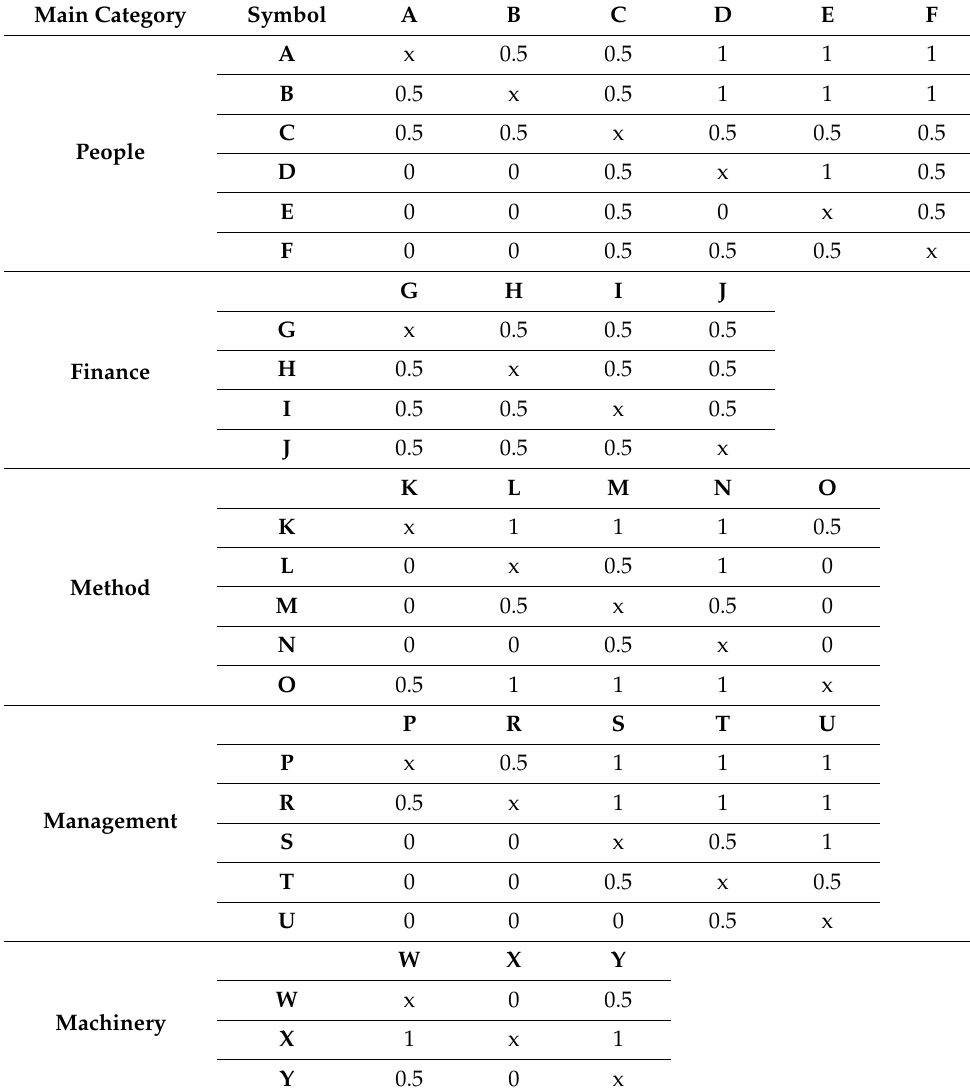
Table 3. Factor significance weights (description of symbols of subsequent